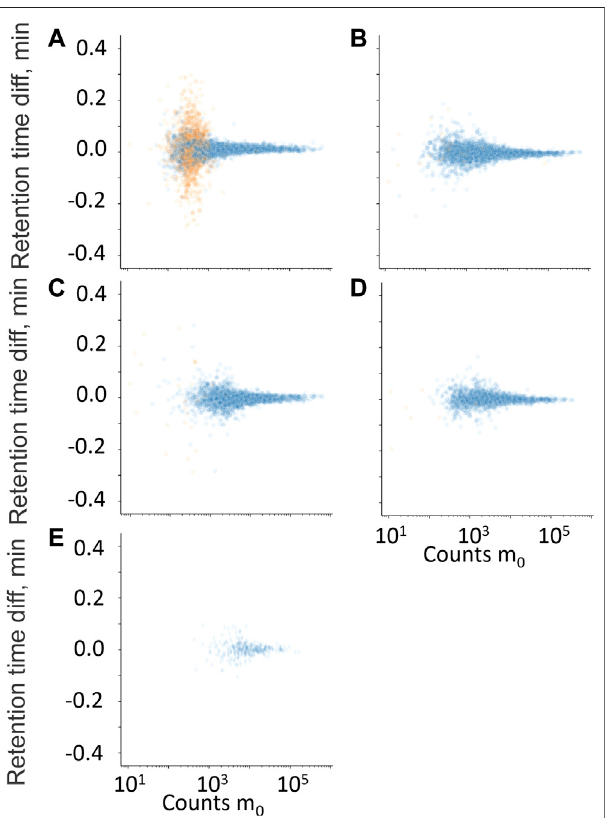
FIGURE 6 | Retention time difference between measured high-energy channel fragment ion and measured m 0 plotted against m 0 counts. (A) Residual fragment ion, f 0 , (B) diagnostic fragment ion f 1 , (C) diagnostic fragment ion f 2 , (D) diagnostic fragment ion f 3 , and (E) diagnostic (cid:129) fragment ion f 4 . Hits from samples with positive quantitative results; from samples with negative quantitative results.